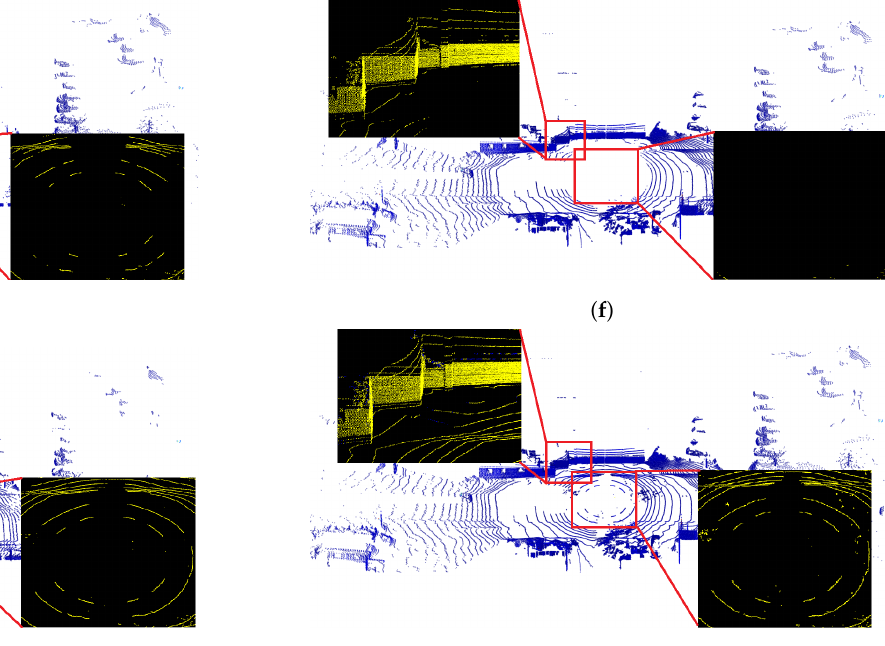
Figure 6. Comparing performance of ROR, SOR, DROR, DSOR, LIOR, and our proposed filter on the fifth scan of Sequence 76 from the WADS under heavy snowfall conditions. The black background visualizes the zoom region from the red box. Blue points in the zoom regions from AGDOR represent the object points that are retained after applying our filter when compared with other methods.